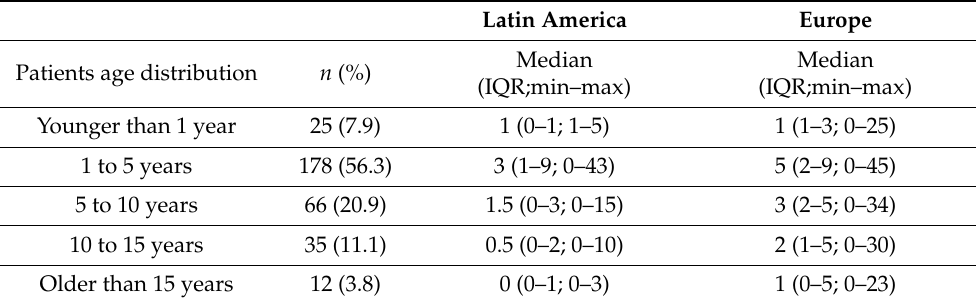
Table 3. Demographic distribution by age groups in Latin America and Europe